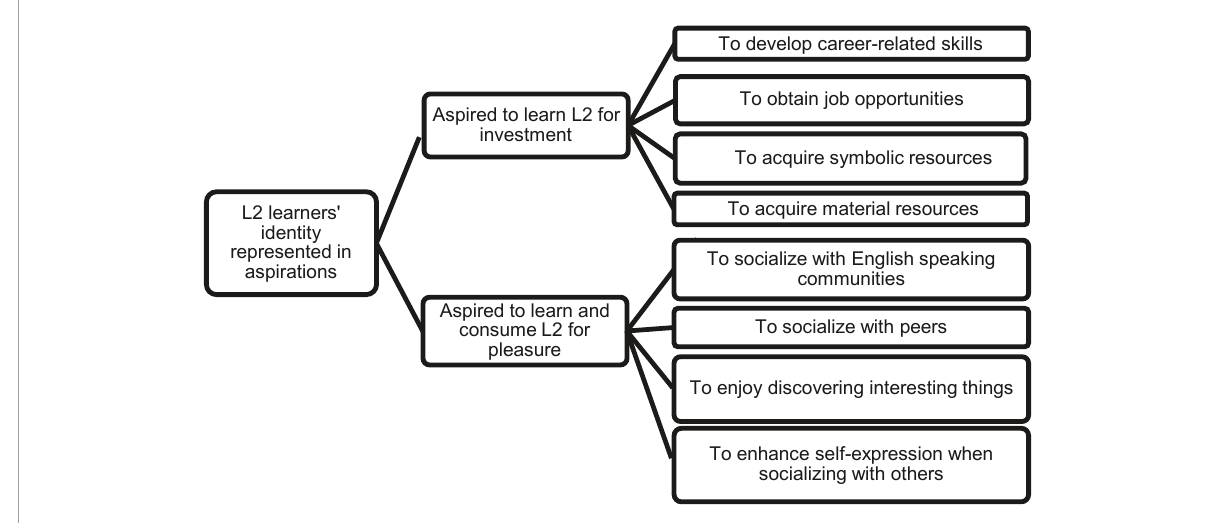
FIGURE1 The new analytical framework of learner identity in terms of aspirations (based on Chen et al., 2020, p.